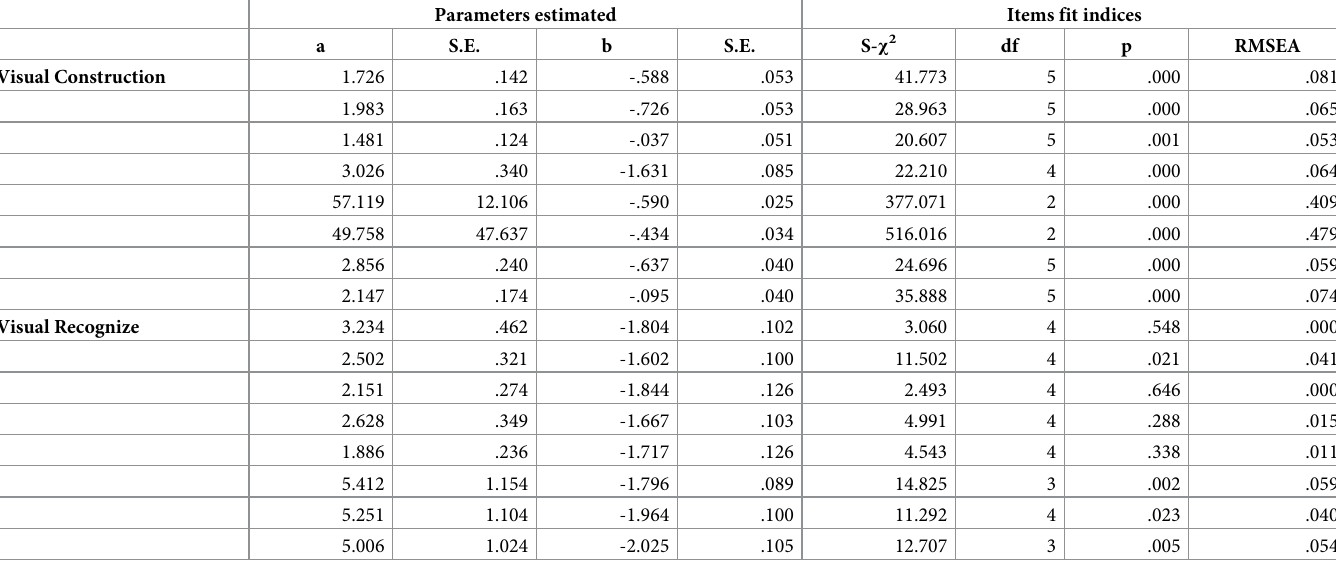
Table 7. Parameters estimated and item fit indices of proposed version of visual construction and visual recognition subscales.